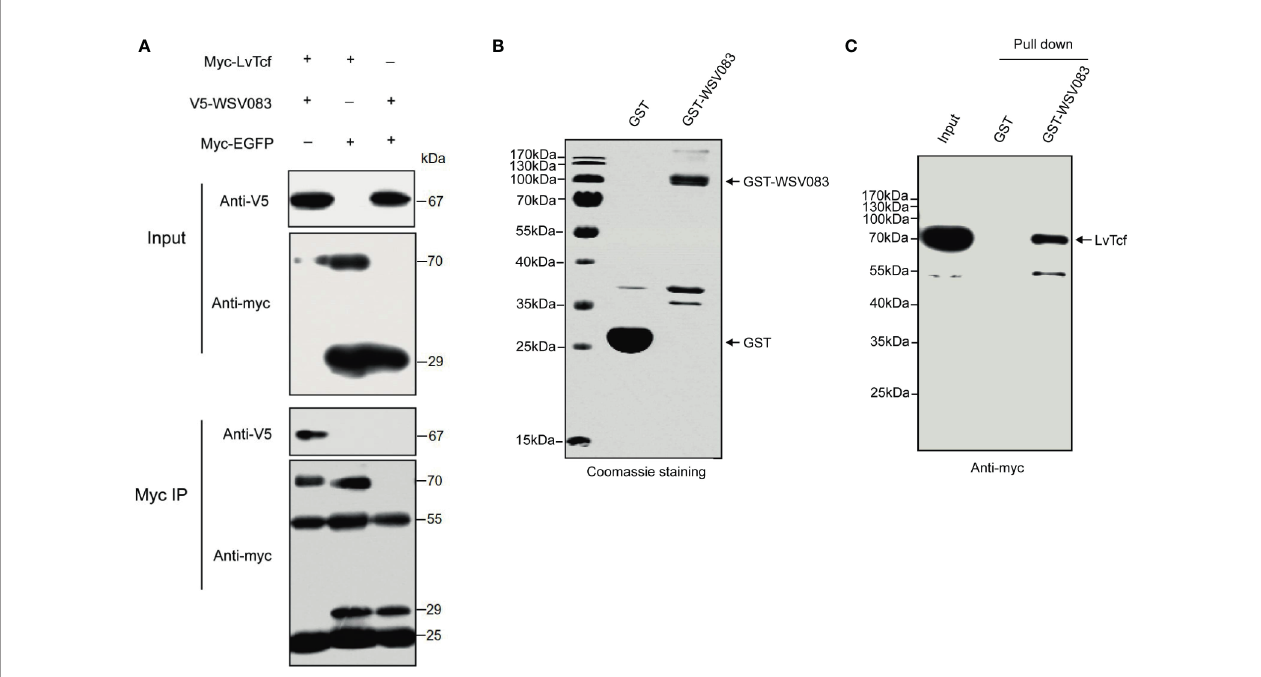
FIGURE 3 | Interaction between LvTcf and WSV083. (A) Co-IP experiments indicated that LvTcf interacted with WSV083 in High Five cells. Myc co-IP was performed using a mouse anti-Myc antibody. Western blotting was performed using a mouse anti-Myc or anti-V5-HRP antibody. (B, C) GST pull-down analysis of the interaction between LvTcf and WSV083. (B) GST and GST-WSV083 were expressed in E. coli BL21 cells and puri fi ed using GST-Sepharose beads. Identical proteins were assessed by SDS-PAGE with Coomassie staining. (C) High Five cells transfected with Myc-LvTcf expression plasmids were lysed and incubated with GST Sepharose beads coupled with GST or GST-WSV083, respectively. The immunoprecipitates were analyzed via western blot using an anti-Myc